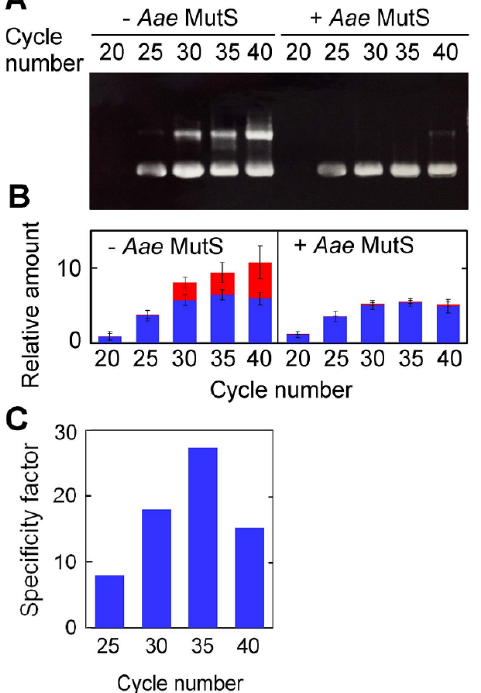
Figure 10. The PCR cycle-dependence of the amplification of a 423-bp region of ttha1806 in the presence or absence of Aae MutS. ( A ) The same experiment as in Figure 7 was performed with 0 or 0.3 μ M Aae MutS; ( B ) The relative amounts of nonspecific and desired amplification products from (A) are shown in red and blue, respectively. The experiments were performed three times. Bars indicate standard deviations. The amounts of the products were normalized by the amount of total products at the end of twentieth cycle in the absence of Aae MutS; ( C ) Specificity factor for 0.3 μ M Aae MutS at each PCR cycle.